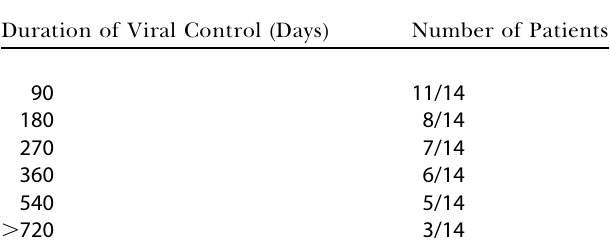
Table 2. Period of Viral Control Achieved Off